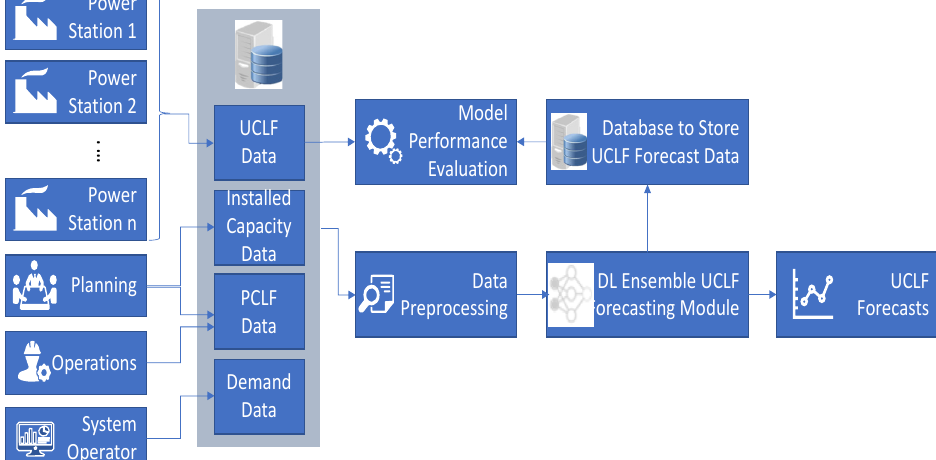
Figure 7. Proposed deep learning UCLF forecasting system.